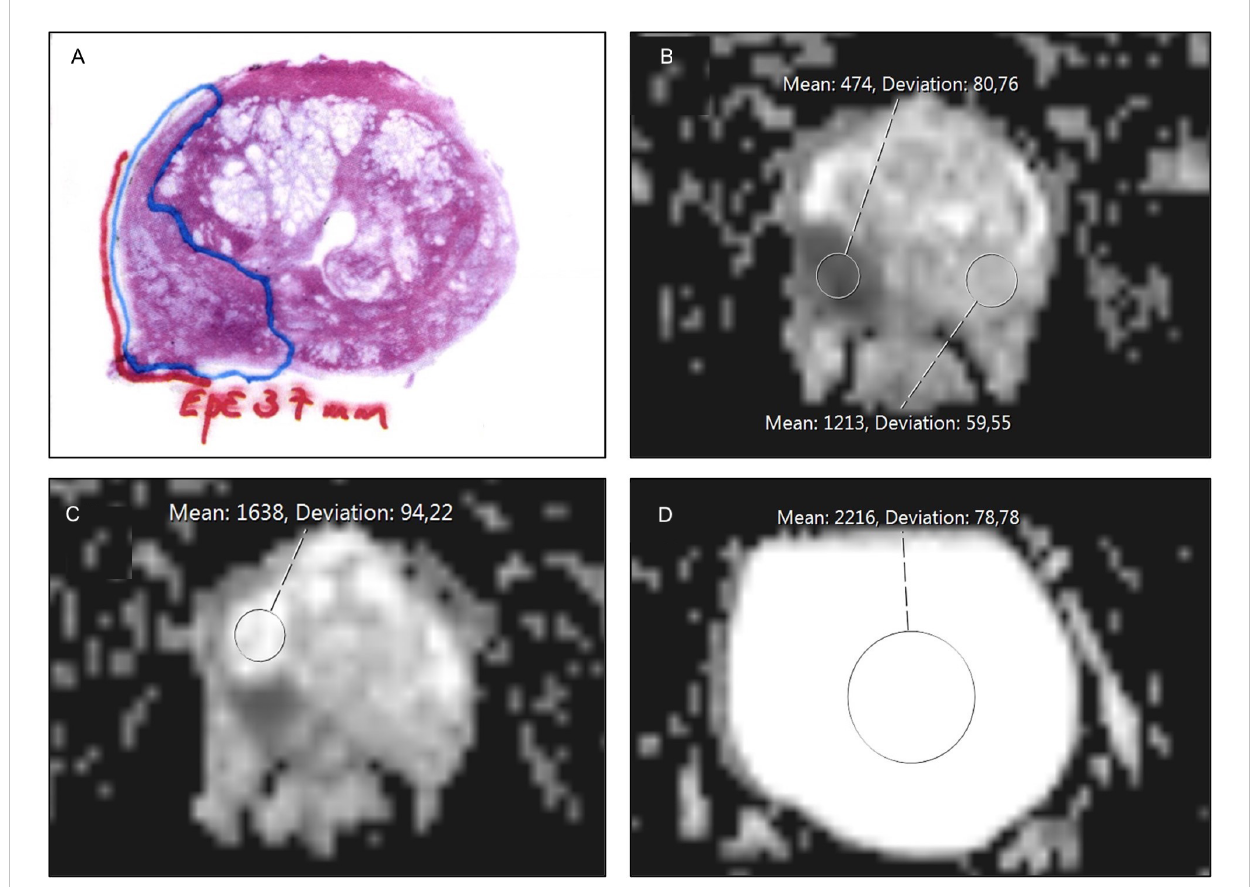
FIGURE 2 Example of a whole mount pathology specimen and placement of a region of interest (ROI) in the ADC map. The specimen was from a 70-year-old man with prostate cancer, PSA level 6.2 ng/mL, and clinical stage T3b. Systematic biopsies showed Gleason 4 + 5 (ISUP grade 5) in 7 of 12 cores. MRI was performed for staging and revealed a 2 x 3 cm PI-RADS 5 lesion in the right peripheral zone (PZ) with fi ndings in line with extraprostatic extension (EPE) and seminal vesicle invasion (SVI). The fi nal staging was pT3a. (A) Midgland whole mount specimen with a large tumor in the right PZ (blue border) with 37 mm EPE (red line). (B) Circular ROI in tumor (ADC lesion = 474 x 10 -6 mm 2 /s) and in contralateral non-tumorous tissue (ADC contralat ref = 1213 x 10 -6 mm 2 /s). (C) Circular ROI drawn in non-tumorous PZ (ADC PZ ref = 1638 x 10 -6 mm 2 /s). (D) Circular ROI in urinary bladder